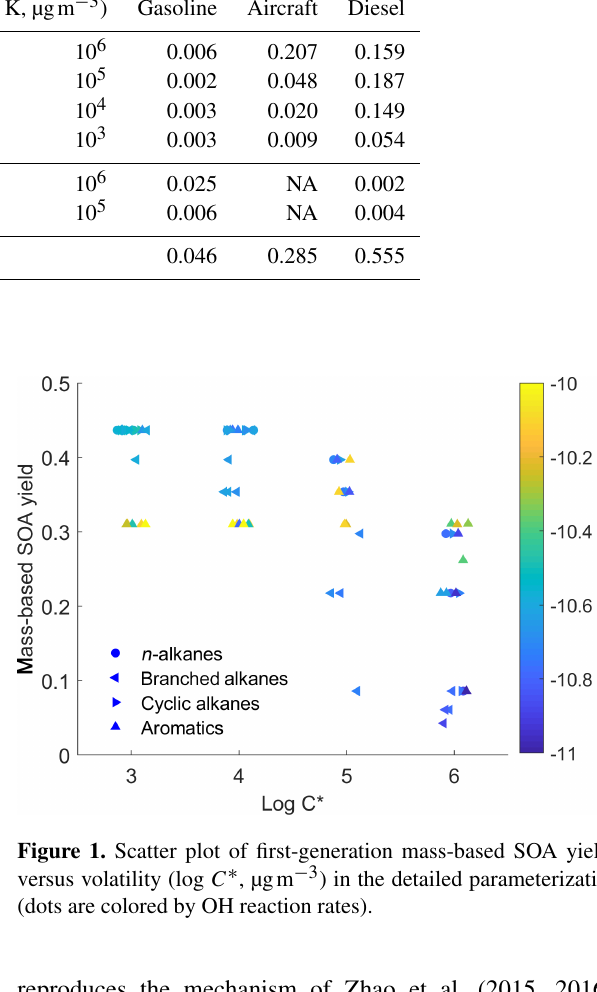
Table 1. Mass fractions (grams per gram of NMOG) of IVOCs in mobile NMOG emission profiles used in CMAQ simulations. Group Volatility Source ( C ∗ at 298K, µgm − 3 ) Non-aromatics